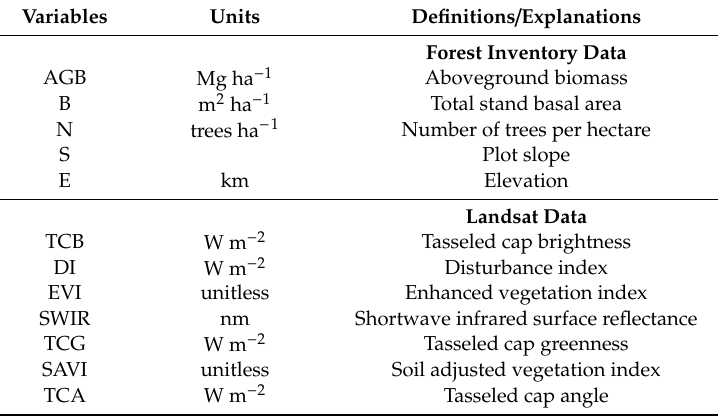
Figure 3. Spatial distribution of forest aboveground biomass (AGB) C density based on 78,458 Forest Inventory and Analysis (FIA) permanent ground plots across the Northern US from 2008 to 2018. Table 2. Definitions and units of variables used in the study for matrix growth models.